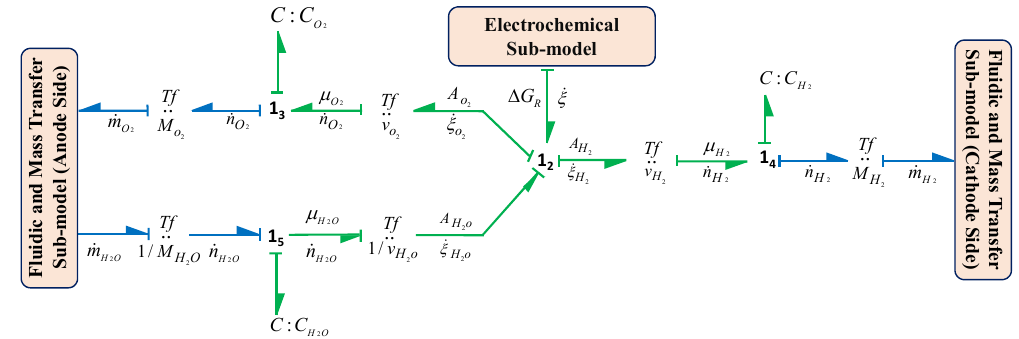
Figure 10. The BG chemical-fluidic sub-model in capsule